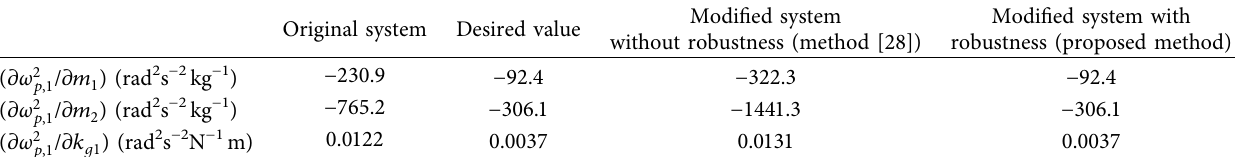
Table 4: Test-case 1: original, desired, and modified system sensitivities of interest.